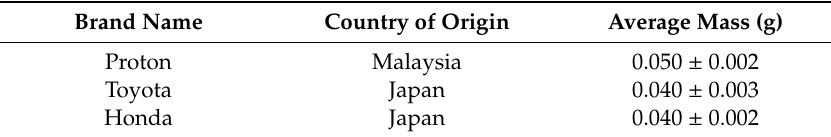
Table 1. Details of windshield glass samples used in this